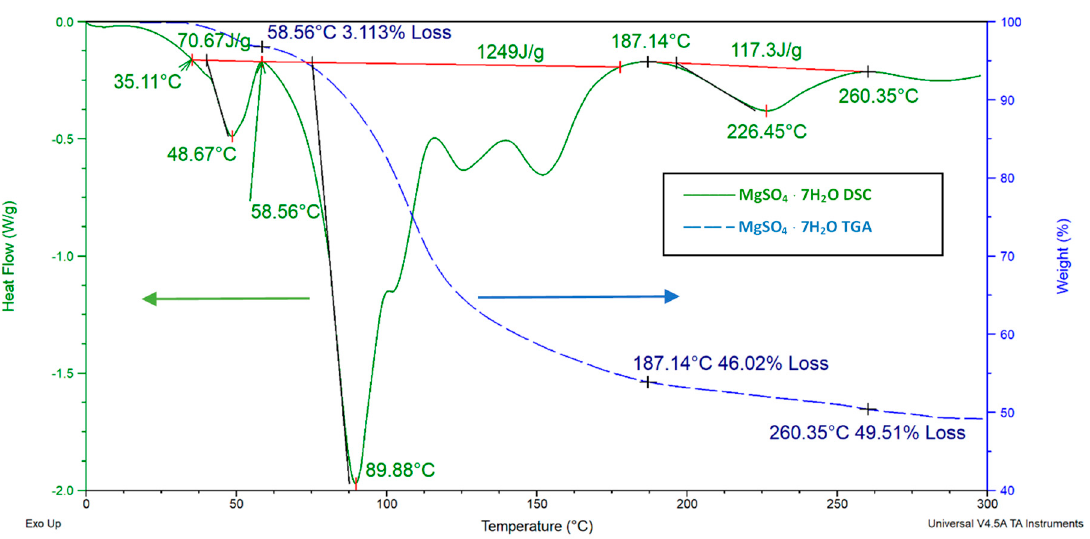
Figure 14. MgSO 4 · 7H 2 O thermogravimetric analysis (TGA) and di ff erential scanning calorimetry (DSC) analysis. For DSC, a 3 ◦ C · min − 1 heating rate from 0 to 300 ◦ C with a 20 mL · min − 1 N 2 flow rate Figure 14. MgSO 4 ⋅ 7H 2 O thermogravimetric analysis (TGA) and differential scanning calorimetry were used. For the TGA test, the utilized method was a 3 ◦ C heating rate from 20 to 300 ◦ C. The total (DSC) analysis. For DSC, a 3 °C ⋅ min − 1 heating rate from 0 to 300 °C with a 20 mL ⋅ min − 1 N 2 flow rate endothermic reaction enthalpy was 1775 J · g − 1 from 0 to 300 ◦ were used. For the TGA test, the utilized method was a 3 °C heating rate from 20 to 300 °C. The total endothermic reaction enthalpy was 1775 J ⋅ g − 1 from 0 to 300 °C.